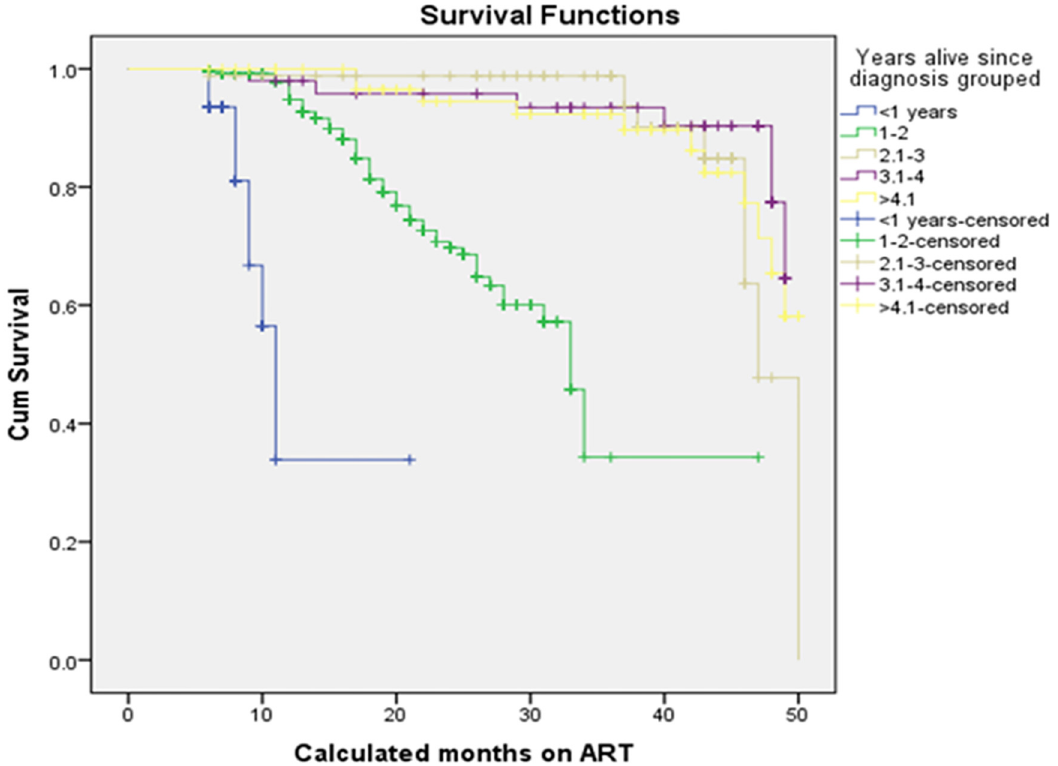
Fig 4. Survival functions of different groups of Years alive since HIV diagnosis of ART patients in private health facilities in Addis Ababa, 2009 – 2013.